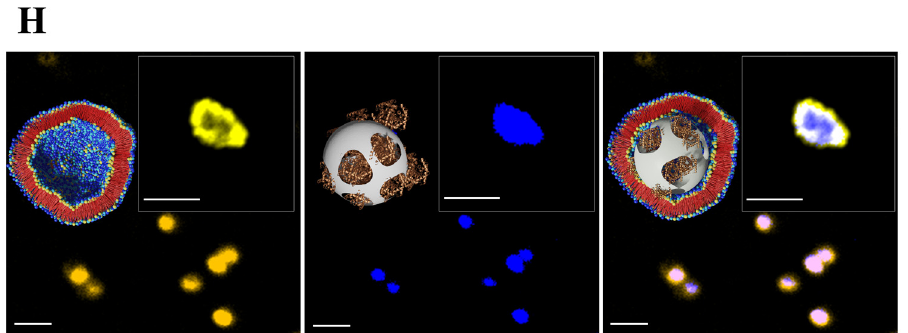
Figure 1. Part I: ( A ) A representative transmission electron microscopy (TEM) image of MSPs (Heulandite-Calcium Mesoporous Aluminosilicate Particles). ( B ) Representative scanning electron microscopy (SEM) image of MSPs. ( C ) X-ray diffraction pattern of the MSPs. ( D , E ) Representative TEM and SEM images of empty liposomes, retrospectively. ( F , G ) Representative TEM and SEM images of LB-MSPs (lipid bilayer coated Heulandite-Calcium Mesoporous Aluminosilicate Particles) (white arrow: showing the lipid layers around the particle). Scale bar for all images, 100 nm. Part II: ( H ) Representative confocal images of a DOPE-LR labeled liposome (yellow color), a FITC-labeled Hb-MSP (purple color), and Hb-loaded LB-MSPs (purple color with yellow outside layer). Scale bar, 2 µm. Inserts: Representative confocal images of DOPE-LR labeled liposome, FITC-labeled Hb-MSP and Hb-loaded LB-MSPs. Scale bar, 1 µm.